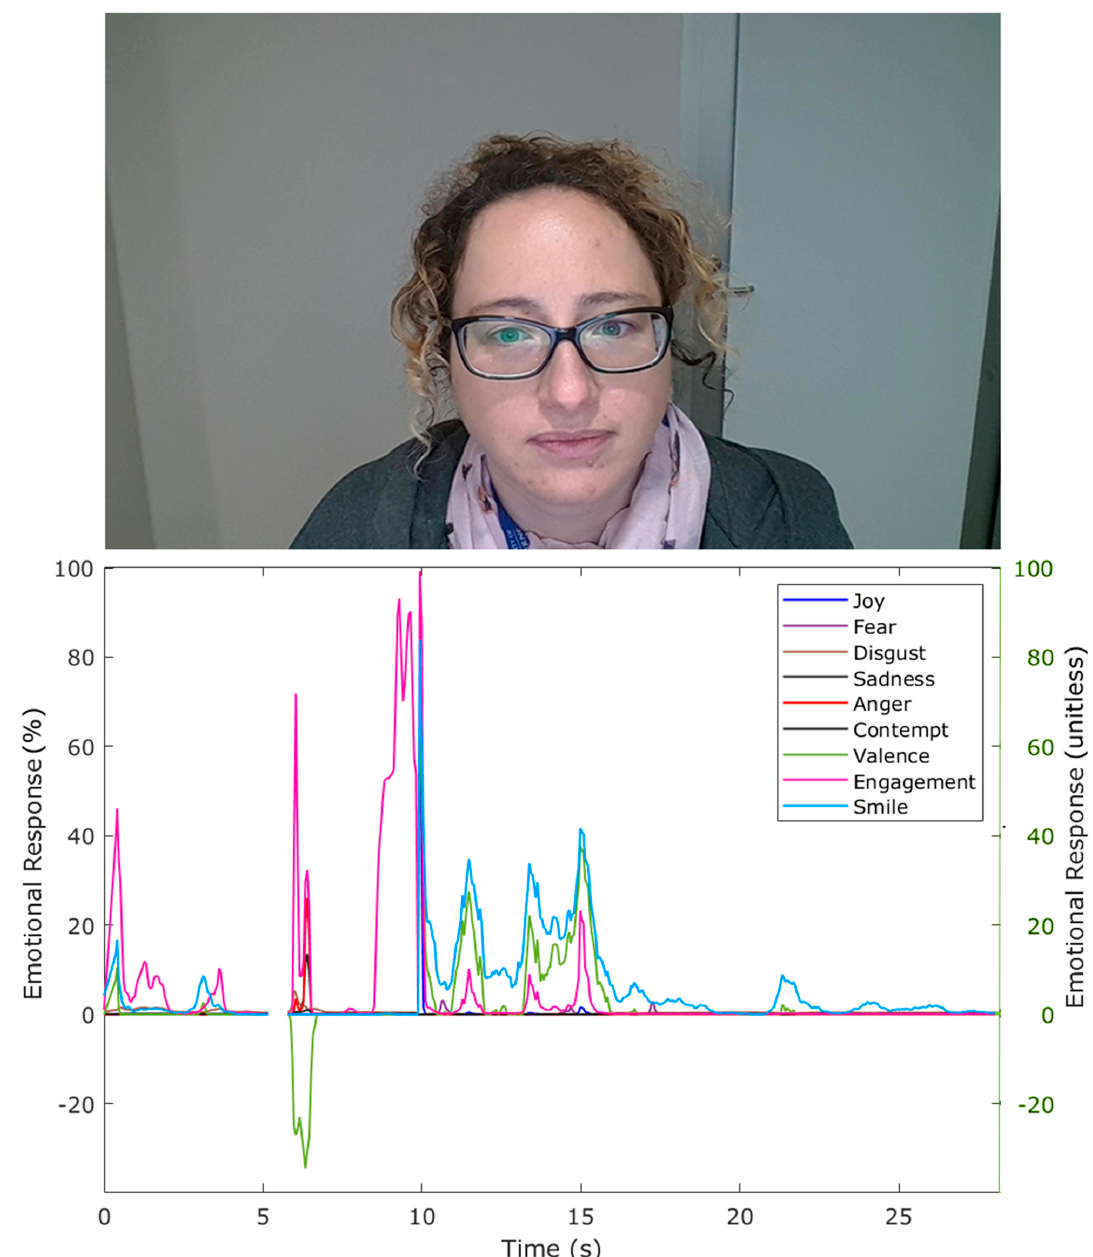
Figure 2. Example of a participant’s video and the emotion analysis plotted from the outputs of the software developed using Affectiva. Left (primary) y -axis corresponds to all emotions except for valence, while right y -axis (secondary) corre- sponds to valence (green).